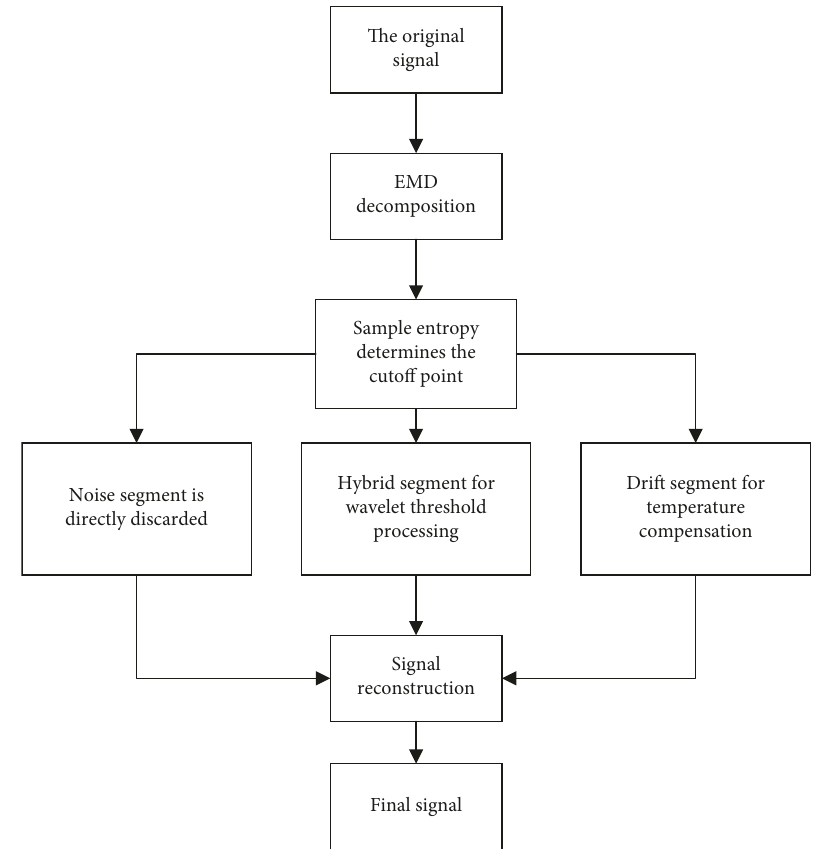
Figure 3: The process of the fusion algorithm.